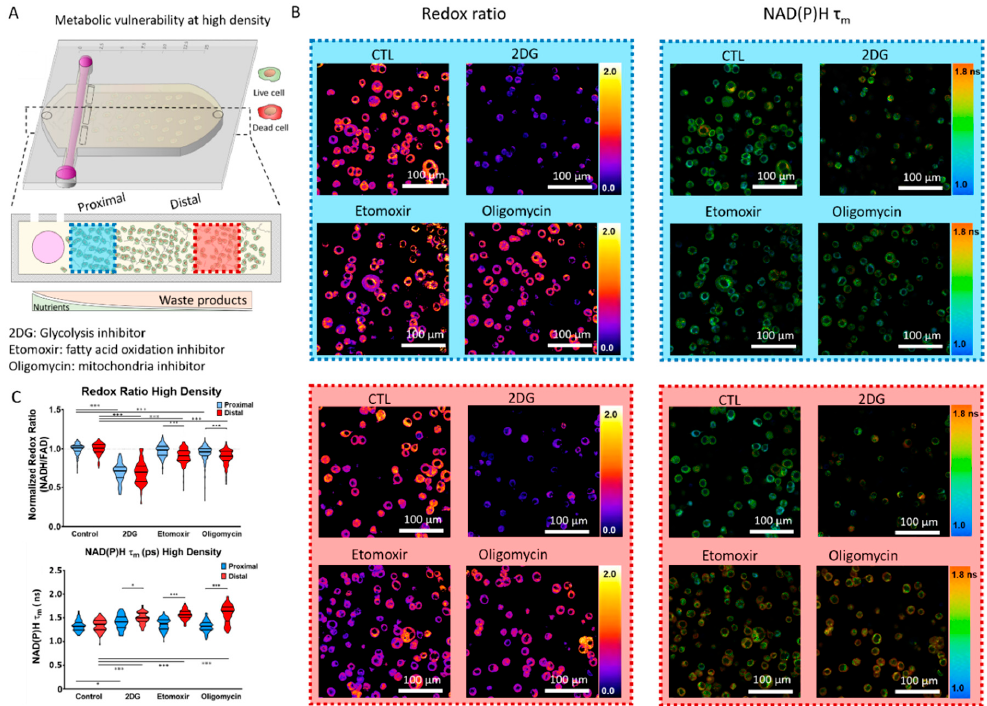
Figure 5. OMI in high cell density cultures. ( A ) Breast cancer MCF7 cells were cultured in the tumor-on-a-chip microdevice at 15 million cells / mL for 24 h in culture medium (CTL), or in the presence of 2-Deoxy-D-glucose (2DG), etomoxir, or oligomycin. After 24 h, cells were imaged using a multi-photon microscopy. NAD(P)H and FAD autofluorescence were visualized and the ratio between NAD(PH) and FAD intensity was used to calculate the MCF7 cell optical redox ratio. NAD(P)H τ m was also calculated to monitor changes in the MCF7 cell metabolic phenotype. Cell metabolism was evaluated in the proximal (blue square) and distal (red square) area. ( B ) Left panels: Multi-photon OMI shows the optical redox ratio for MCF7 cells located in the proximal and distal area, respectively. Right panels: Multi-photon OMI shows the NAD(P)H τ m of MCF7 cells located in the proximal and distal area, respectively. ( C ) Top graph: Violin plot shows the optical redox ratio normalized to the respective control (proximal or distal area) for each condition. Bottom graph: Violin plot shows the analysis of NAD(P)H τ m in the proximal and distal area. * and *** denote p -value < 0.05 and 0.001, respectively.